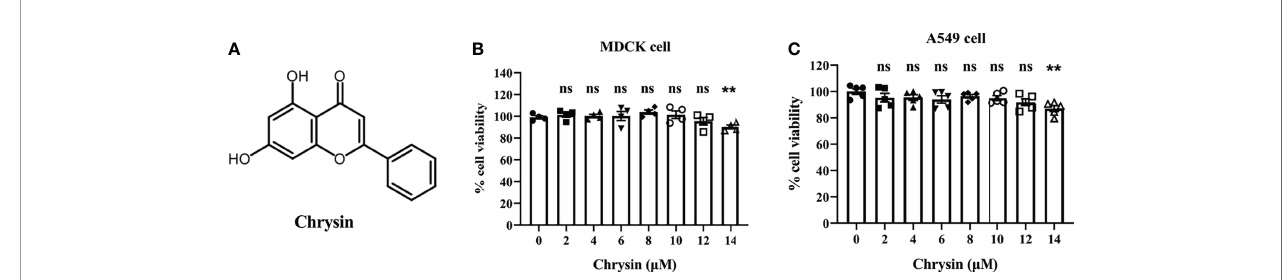
FIGURE 1 | Chemical structure of chrysin and its cytotoxicity assay in MDCK and A549 cells. (A) Chemical structure of chrysin. MDCK (B) and A549 cells (C) were treated with increasing concentrations (0, 2, 4, 6, 8, 10, 12, 14 m M) of chrysin for 24 hours. Cell viability was assessed by the CCK-8 assay. Data was presented as mean ± SEM. **P < 0.01 compared with control (0 m M) by one-way ANOVA with Dunnett ’ s multiple comparisons test. ns, no signi fi cant difference. All data are representative of three